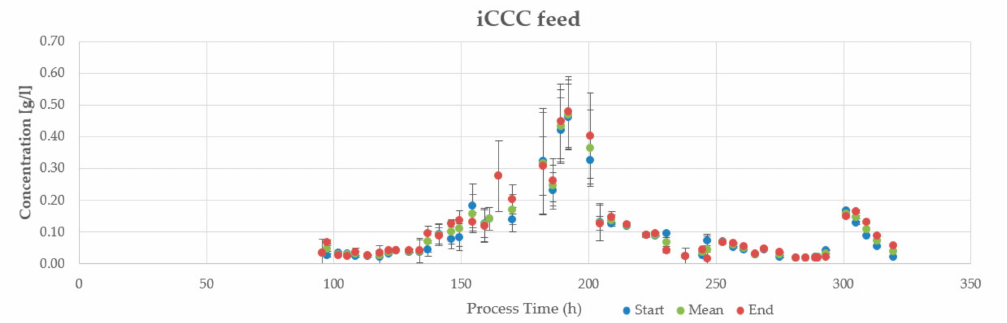
Figure 22. Feed concentration of the feed for the iCCC (integrated counter-current chromatography). Error bars depict the double determination of the product